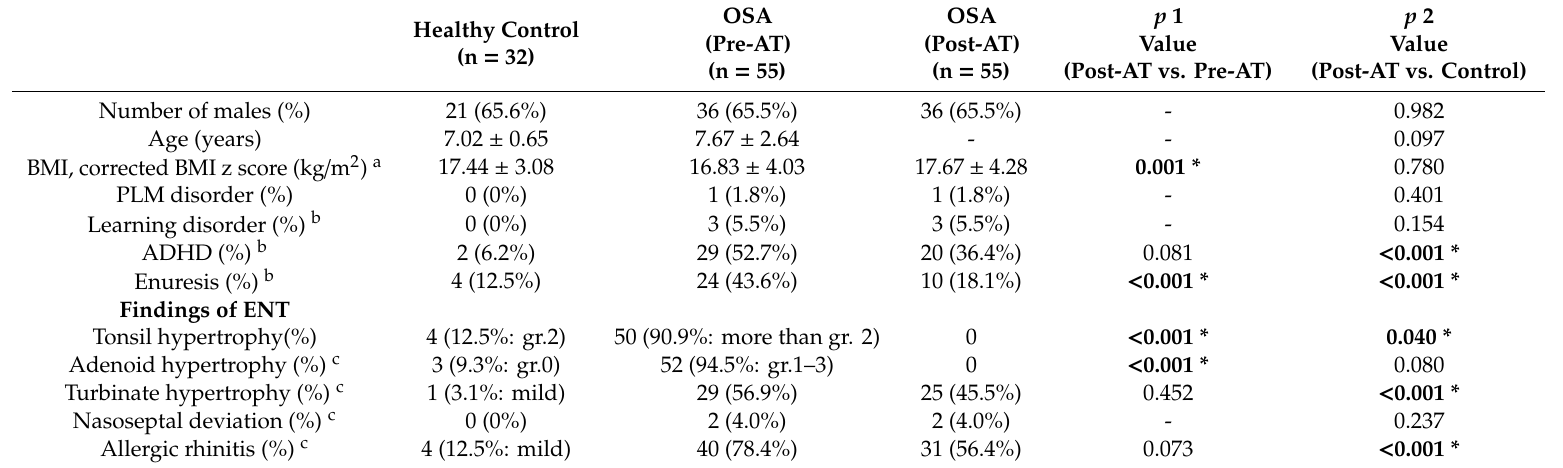
Table 1. Demographic characteristics of children with obstructive sleep apnea (OSA) and healthy